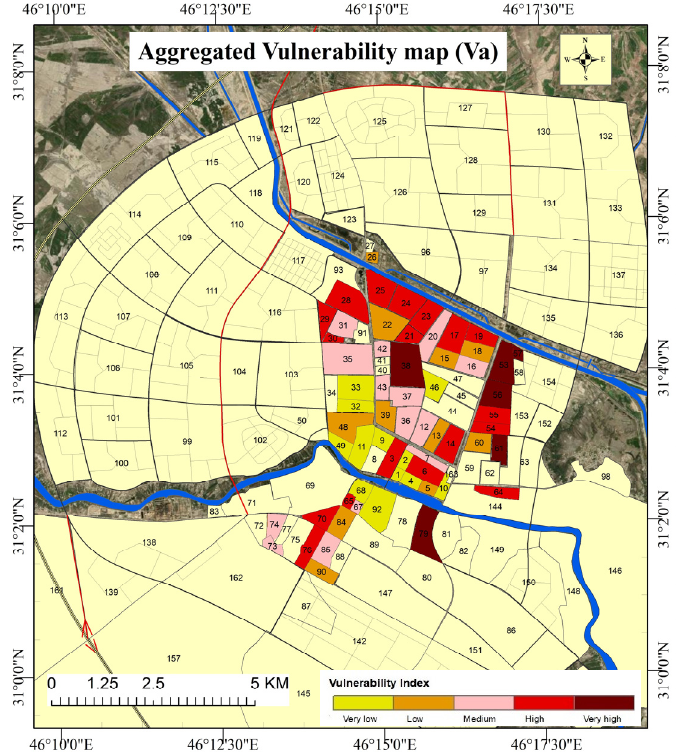
Figure 17. Classification of city neighbourhoods based on the aggregated vulnerability indicators (Va).